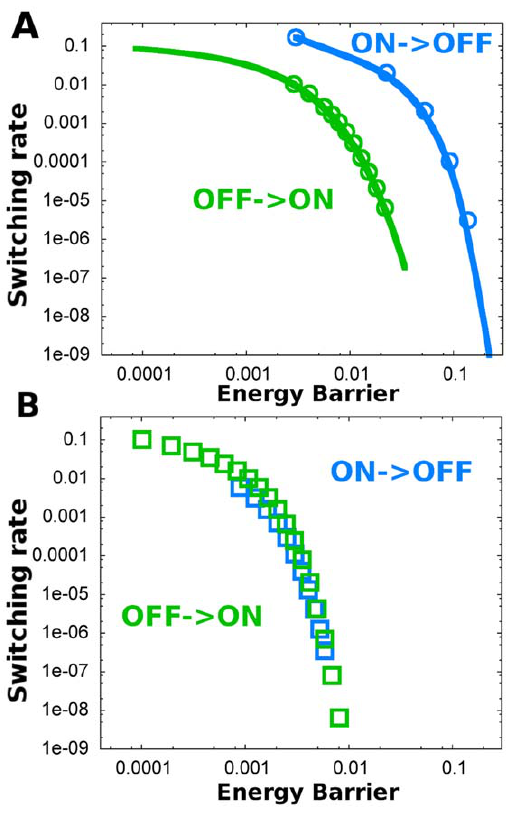
Figure 3. Intrinsic multiplicative noise generates an asymmetry in switching rates. A Switching rate versus energy barrier for the stochastic system with intrinsic multiplicative noise. The lines represent the values obtained through theoretical MFPT calculations, Eq (16), and the circles represent the values obtained through simulation (Gillespie and Langevin are identical). In both panels, the energy barriers were calculated from Eq (3). Blue colour corresponds to switching from ON to OFF and green color corresponds to OFF to ON switching. B Switching rate versus energy barrier for the additive noise case. Notice how the rates for both states keep the same relation with the energy barriers. Colour code is as in previous panel. Symbols correspond to theoretical MFPT calculations. Simulations are in perfect agreement, but are not represented for clarity. In both panels, the nondimensional cell volume is V ~ 94 : 9